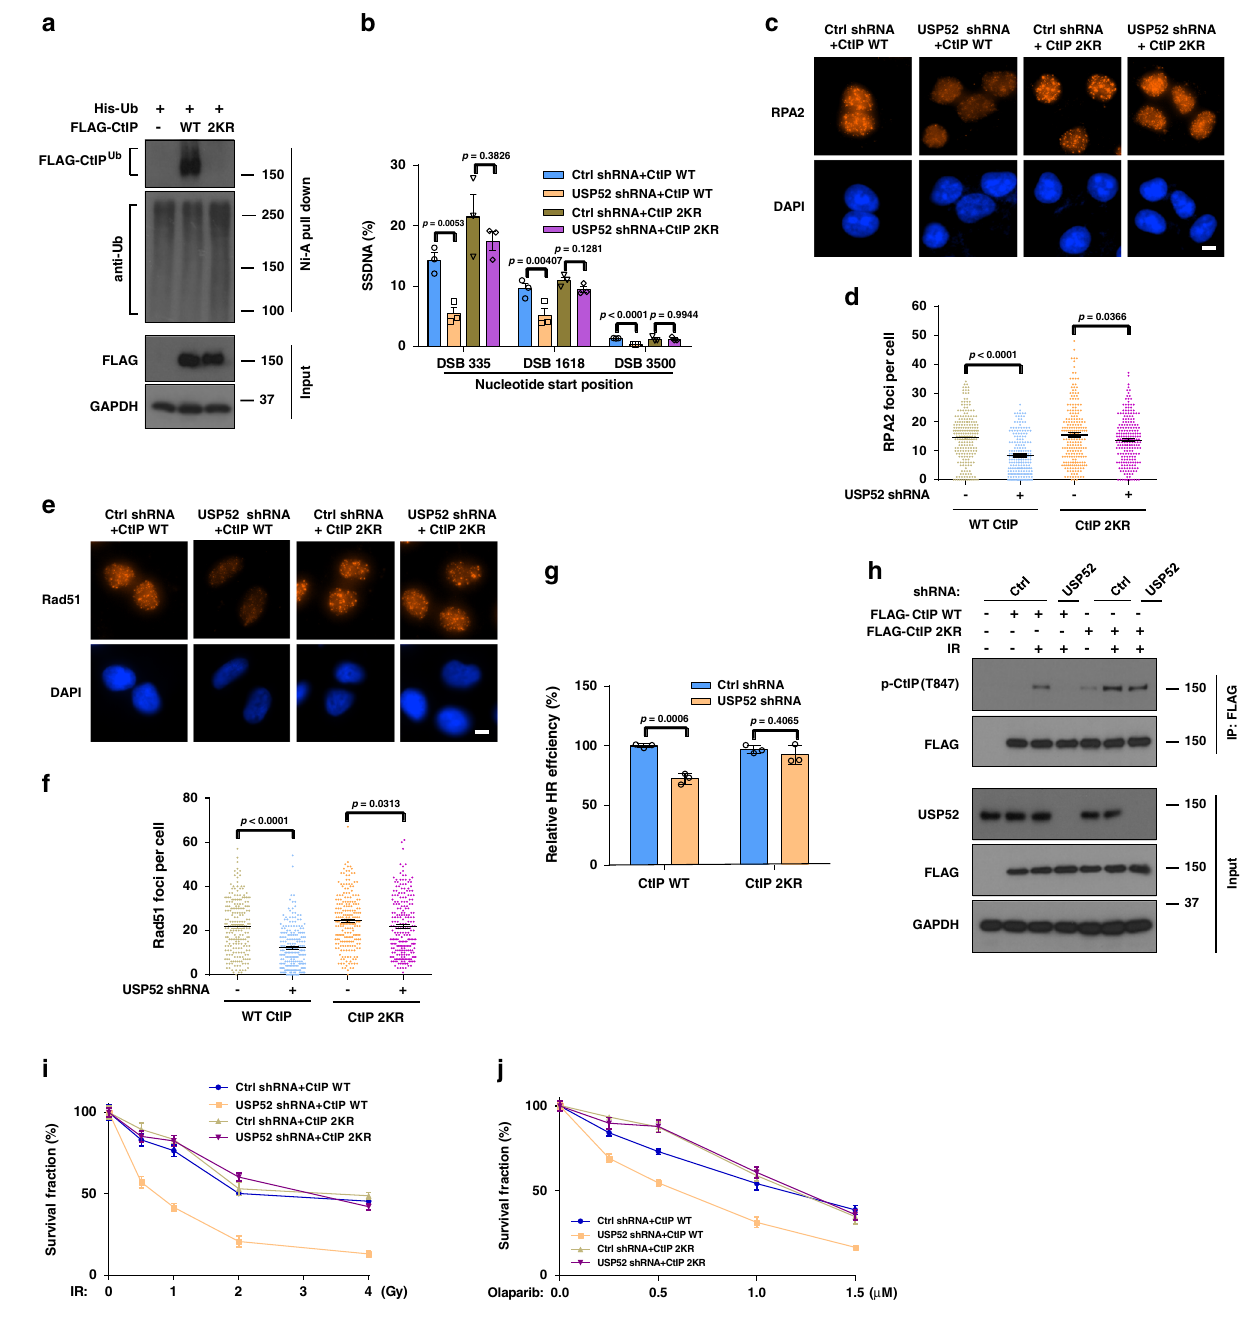
Fig. 4 Deubiquitination of CtIP by USP52 is important for DNA end resection and HR. a HEK293T cells were transfected with WT CtIP or CtIP 2KR for 24 h before harvesting and immunoprecipitation with nickel (His) beads. Blots were detected by indicated antibodies. b Control or USP52-depleted ER- AsiSI U2OS cells were transfected with WT CtIP or CtIP 2KR for 24 h, and then cells were treated with 4-OHT to induce DSB. Cells were harvested for DNA end resection analysis measured by qPCR assay. Each bar represents SEM from three independent experiments. c – f Representative images ( c , e ) and quanti fi cation ( d , f ) of RPA2 ( c , d ) and Rad51 foci ( e , f ) in control or USP52 knockdown U2OS cells which were transfected with WT CtIP or CtIP 2KR for 24 h before treated with 2 Gy IR for another 2 h or 5 Gy IR for 5 h. Data are representative of three independent experiments. Each dot represents a single cell, and more than 200 cells were counted in each group for this experiment. Error bars represent SEM from this experiment. Scale bar, 10 μ m. g Control or USP52-depleted HEK293T cells which were transfected with WT CtIP or CtIP 2KR were subjected to DR-GFP-based HR assay. Data are presented as mean values± SEM from three independent experiments. h Control or USP52-depleted HEK293T cells were transfected with WT or 2KR mutant of CtIP for 24 h prior to be treated with 5 Gy IR. Cells were then harvested and immunoprecipitated with anti-FLAG agarose beads to detect the phosphorylation of CtIP at T847. i , j The sensitivity of control or USP52-depleted cells stably expressing WT CtIP or 2KR truncates in response to IR ( i ) or PARPi ( j ) were analyzed by colony formation assay. Error bars represent SEM from three independent